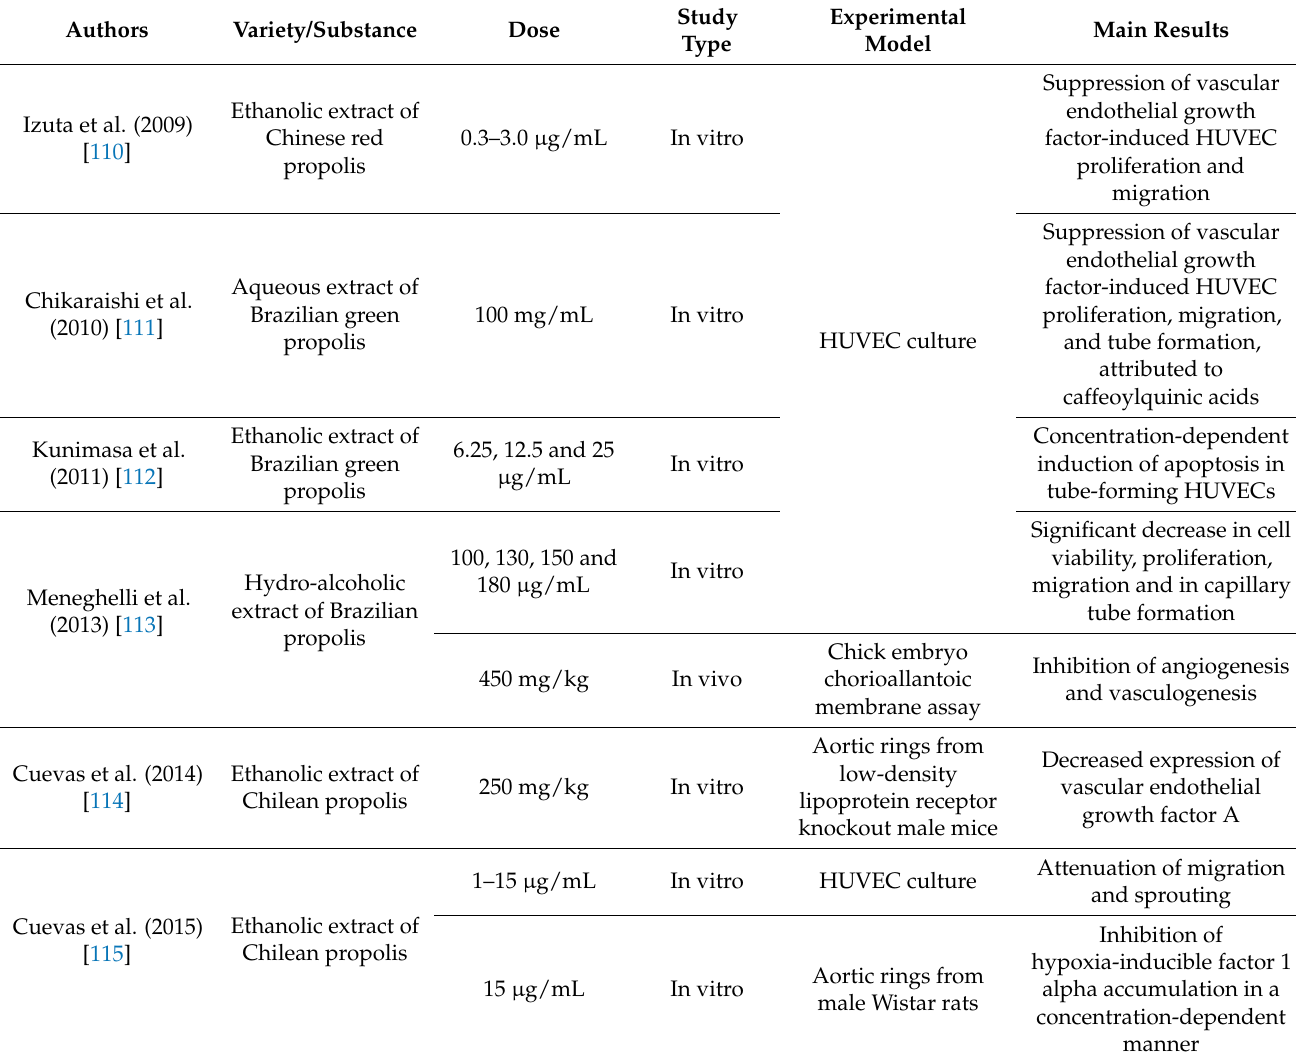
Table 5. Description and main results of the most relevant studies assessing the anti-angiogenic activity of propolis.